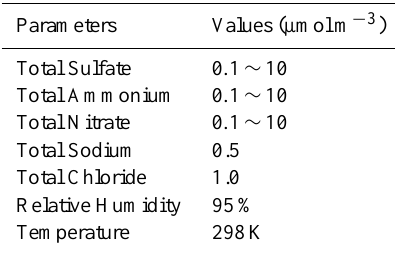
Table 2. Input cases for testing of HDDM-PM using stand-alone